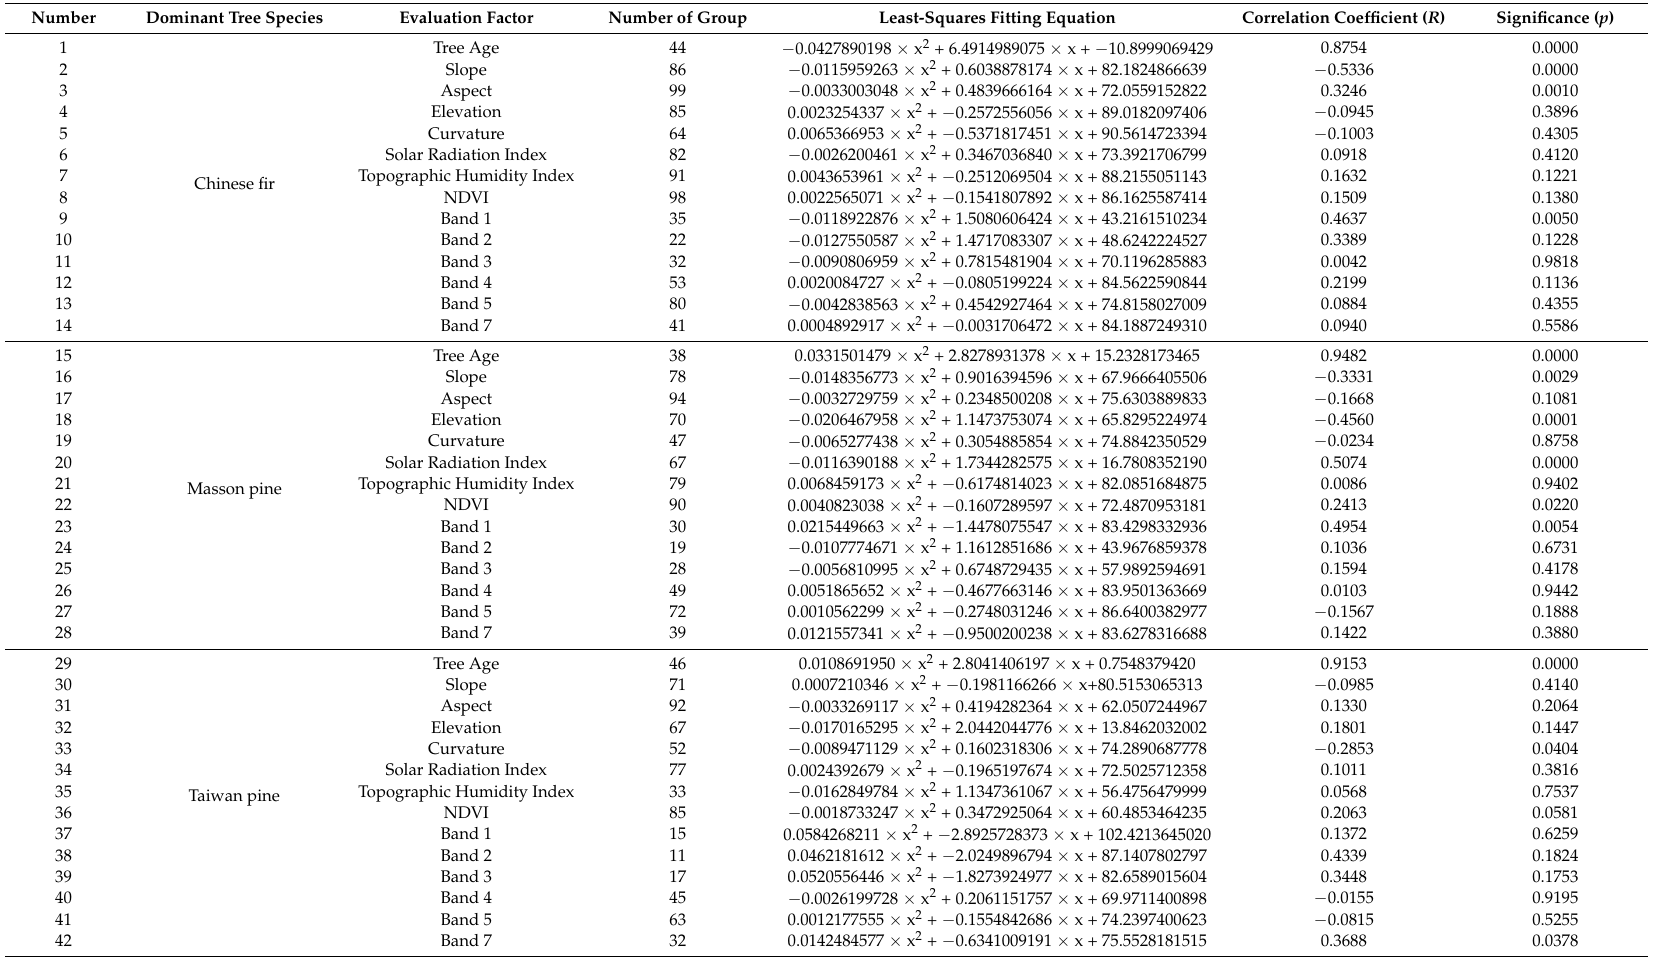
Table 3. The least-squares fitting equations for the evaluation factors for Scheme